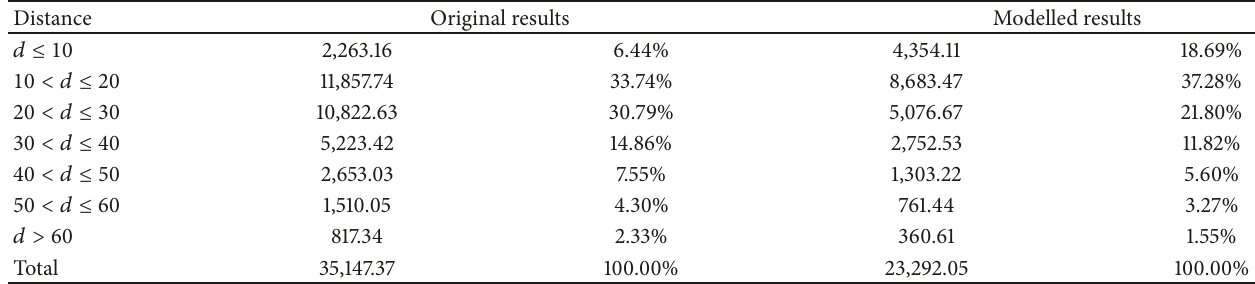
Table 1: Efficiency comparison of running distances. The data in the 2nd and 4th columns are accumulationof corresponding distances; unit: km.